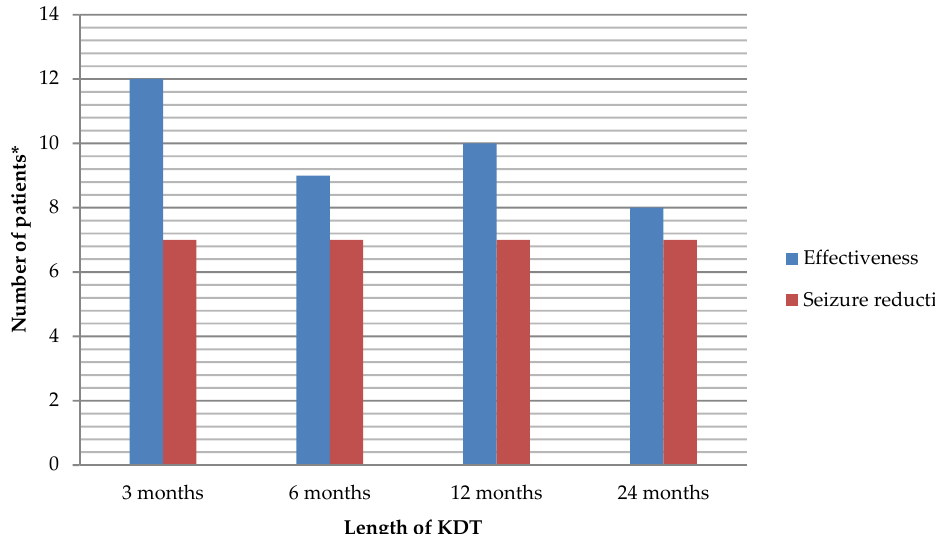
Figure 3. Global effectiveness and significant seizure reduction of the ketogenic dietary therapies (KDT) in patients with confirmed or suspected glucose transporter type 1 deficiency syndrome (GLUT1DS). * Each column represents the total number of patients without distinguishing the type of diet. Total number of patients on KDT: 17 at 3 months, 13 at 6 months, 10 at 12 months, and 8 at 24 months.